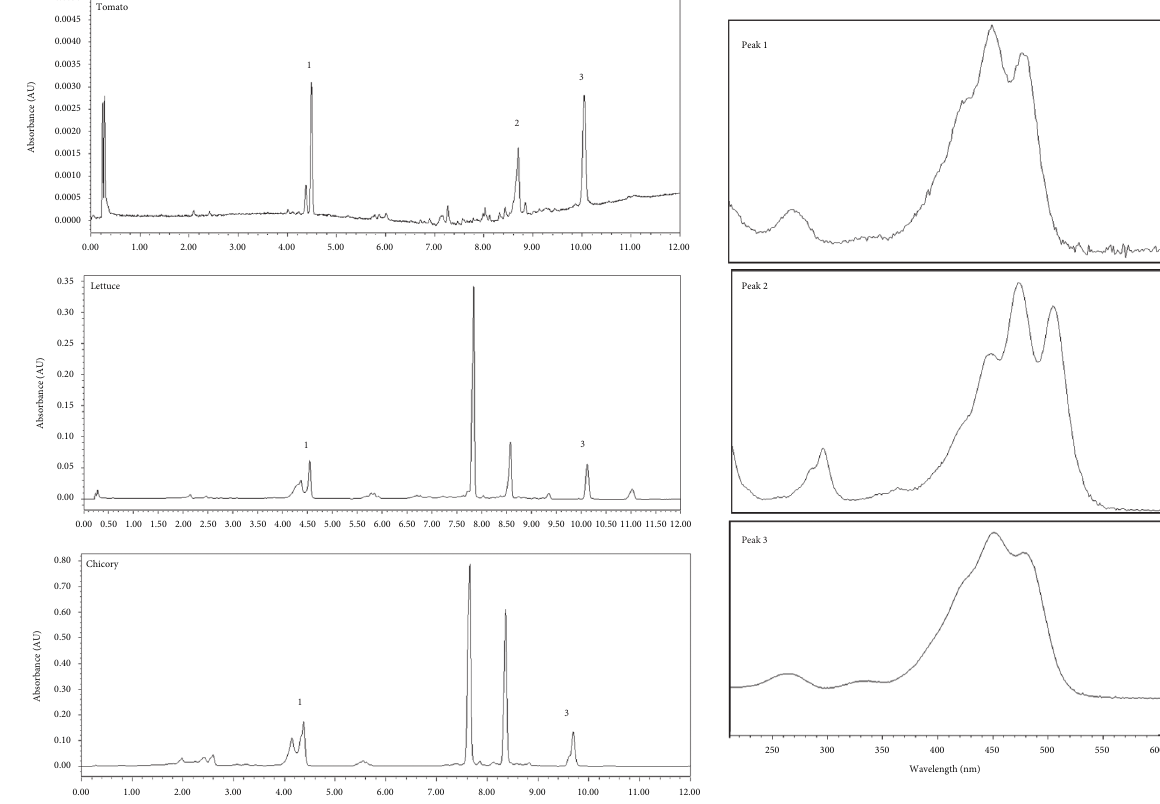
Figure 4: Representative UPLC profiles of carotenoids from tomato, lettuce, and chicory, and spectra of corresponding carotenoids. Table 2: Plant growth parameters of tomatoes ( Solanum lycopersicum ) according to companion planting ratio with sunflower ( Helianthus annuus ) in green roofs at 88 days after planting.